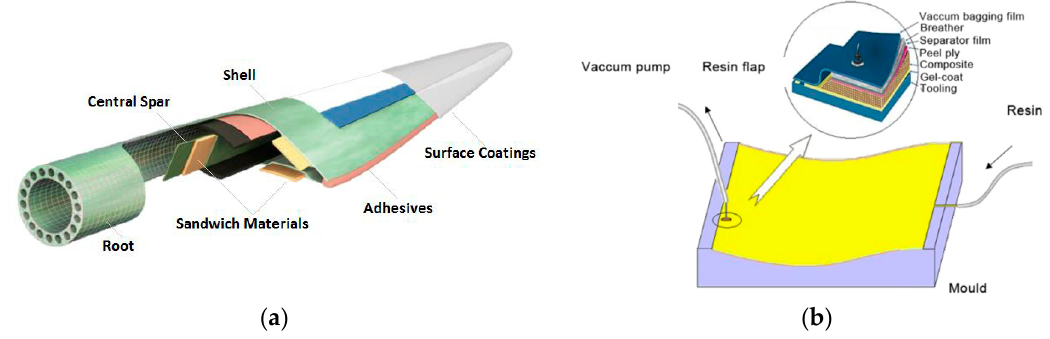
Figure 3. ( a ) Materials used in a typical blade cross section [15] and ( b ) surface-coated mould area and tooling materials used [15].